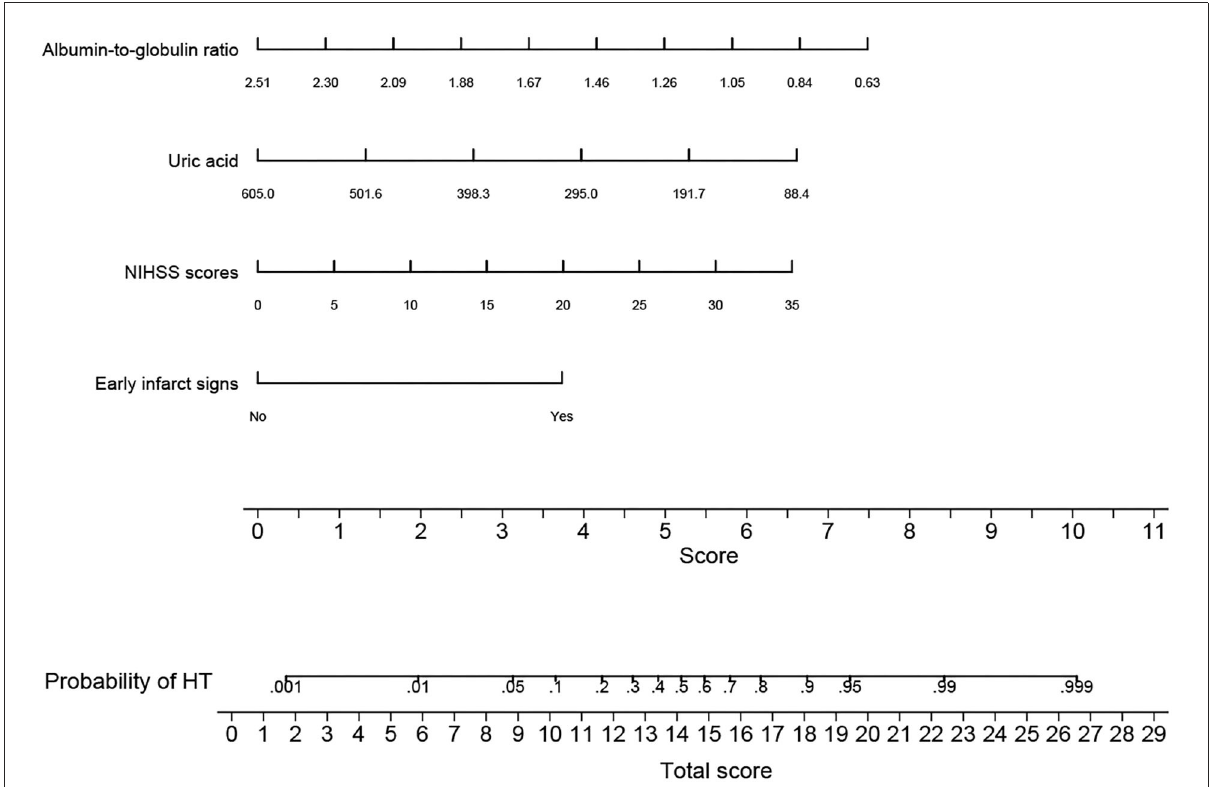
FIGURE2 Nomogram for predicting HT after intravenous thrombolysis. The nomogram consists of four predictors, each of which is given a preliminary score (0 – 11). The total scores were obtained by summing all the preliminary scores of each of the four predictors. The estimated probability of hemorrhagic transformation was obtained from the nomogram according to the total score. For example, a patient with an early infarct sign, baseline NIHSS scores of 10, a uric acid level of 295 µ mol/L, and an albumin-to-globulin ratio of 1.05 would have a total of 15.7 scores. The probability of HT after intravenous thrombolysis was approximately 70% for the patient. NIHSS, National Institute of Health Stroke Scale; HT, hemorrhagic transformation; CT, computed tomography.